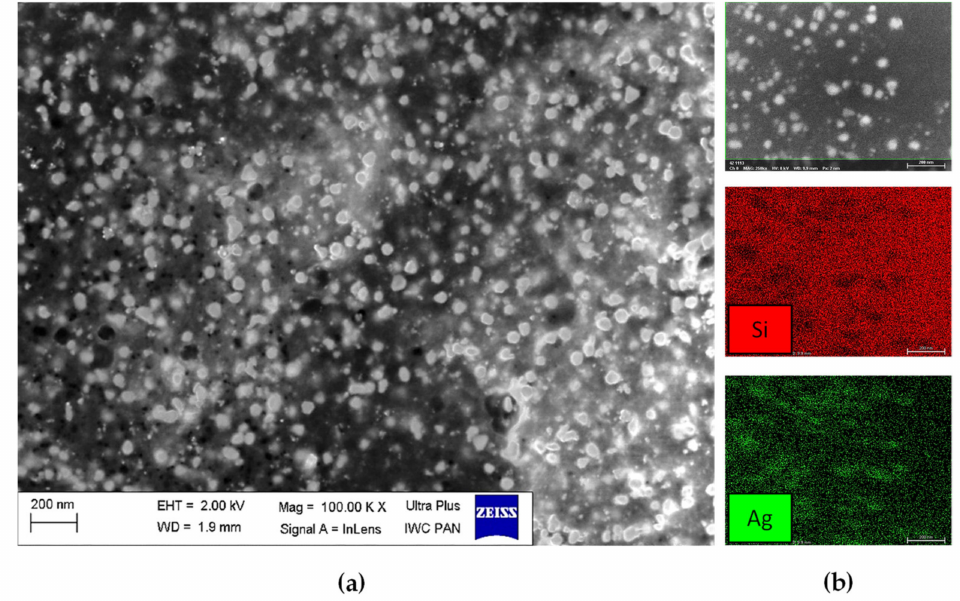
Figure 5. SEM image ( a ) and EDS mapping of the elemental species ( b ) of AgNPs sample prepared with 5 mL of infusion of C. incanus .